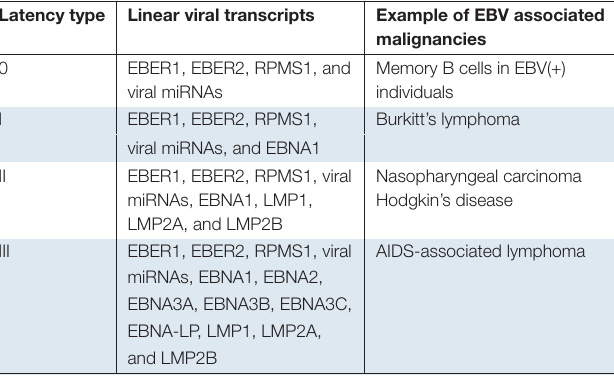
TABLE 1 | EBV linear transcripts in different types of